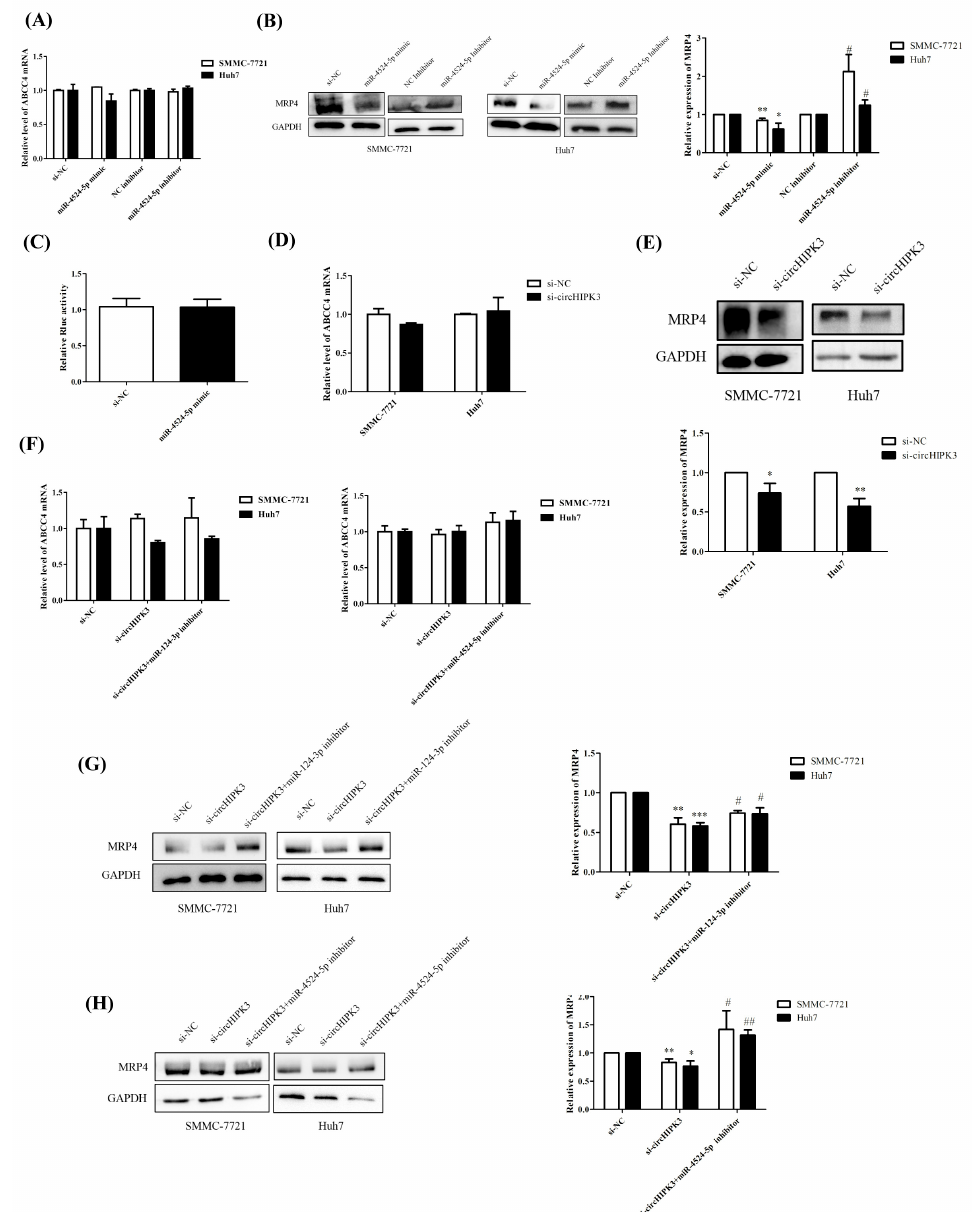
Figure 4. circHIPK3-miR-124-3p/miR-4524-5p axis involved in MRP4 upregulation. ( A , B ) Overexpression of miR-4524-5p decreased the MRP4 expression at the protein but not mRNA level. ( C ) No significant difference between the luciferase activity of miR4524-5p and negtive control. ( D , E ) Silencing of circHIPK3 decreased the MRP4 expression at the protein but not mRNA level. ( F ) Cotransfection with si-circHIPK3 and miR-124-3p or miR4524-5p inhibitors showed no change in MRP4 mRNA levels. ( G , H ) The circHIPK3-associated suppression of MRP4 at the protein level was rescued by inhibition of miR-124-3p or miR-4524-5p.“si-circHIPK3+miR-124-3p inhibitor” stands for cotransfection with si-circHIPK3 and miR-124-3p. “si-circHIPK3+miR-4524-5p inhibitor” stands for cotransfection with si-circHIPK3 and miR-4524-5p. Results are expressed as mean ± standard error of the mean (SEM) of at least three independent experiments. Differences between two experimental groups were analyzed by the Student’s t test. * p < 0.05, ** p < 0.01, *** p < 0.001, compared with control group. # p < 0.05, ## p < 0.01.